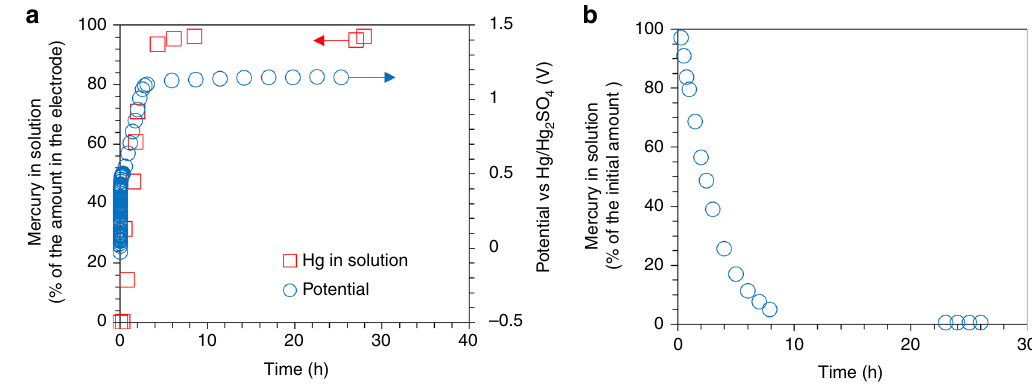
Fig. 5 Regeneration of nano- fi lm electrodes and the use of large surface area electrodes. a The increase of mercury concentration in pure 1 mol L − 1 nitric acid solution upon applying a 40 µ A current to a 100 nm platinum electrode previously used for mercury retrieval (red squares, left axis), and the recorded potential (blue circles, right axis). Counter electrode: platinum wire. Reference electrode: Hg/Hg 2 SO 4 . b Retrieval of mercury from 50 mL 1 mol L − 1